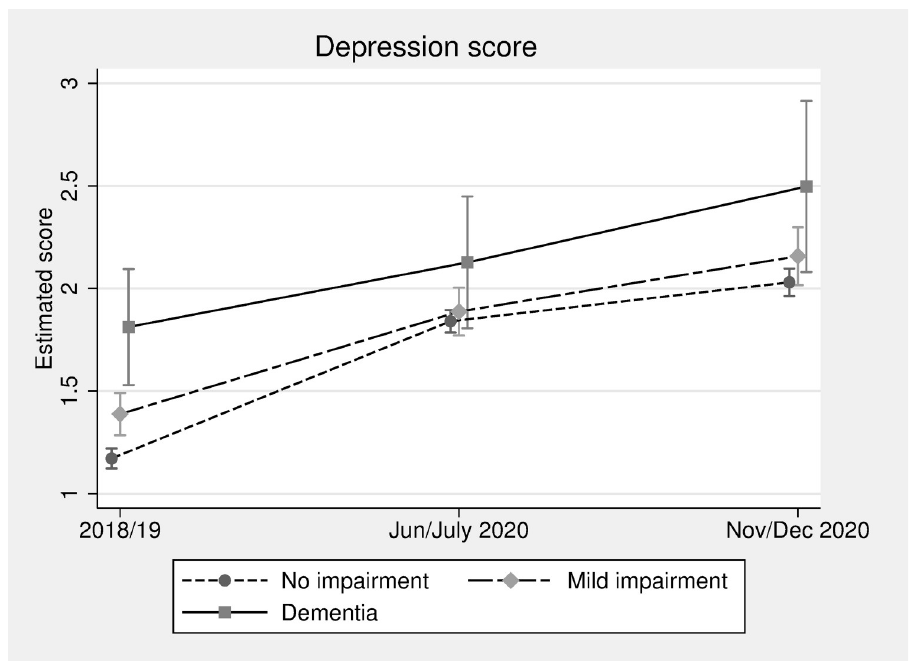
Fig 1. Depression score (CES-D) over time by cognitive function (estimated scores and 95% confidence intervals, adjusted for all available covariates).